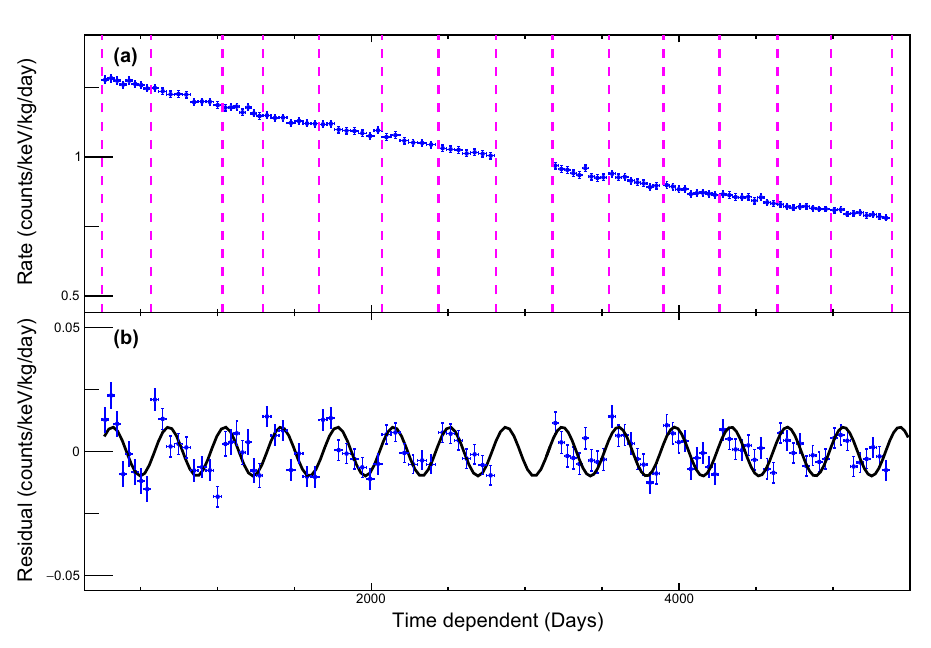
Figure 7. An example of a simulation of the DAMA/LIBRA experiment in the single-hit 2–6 keV region. ( a ) One sample of the simulated experiment of the time-dependent event rates for the DAMA/LIBRA assuming COSINE-100’s background composition (points) is presented for 13 -year cycles. Vertical lines represent the start and end of each cycle used by the DAMA/LIBRA experiment. ( b ) The residual spectrum applying the DAMA-like method (points) is fitted with the sinusoidal function (solid line). Although no dark matter signals are inserted in this simulated data, strong modulation is observed from the DAMA-like